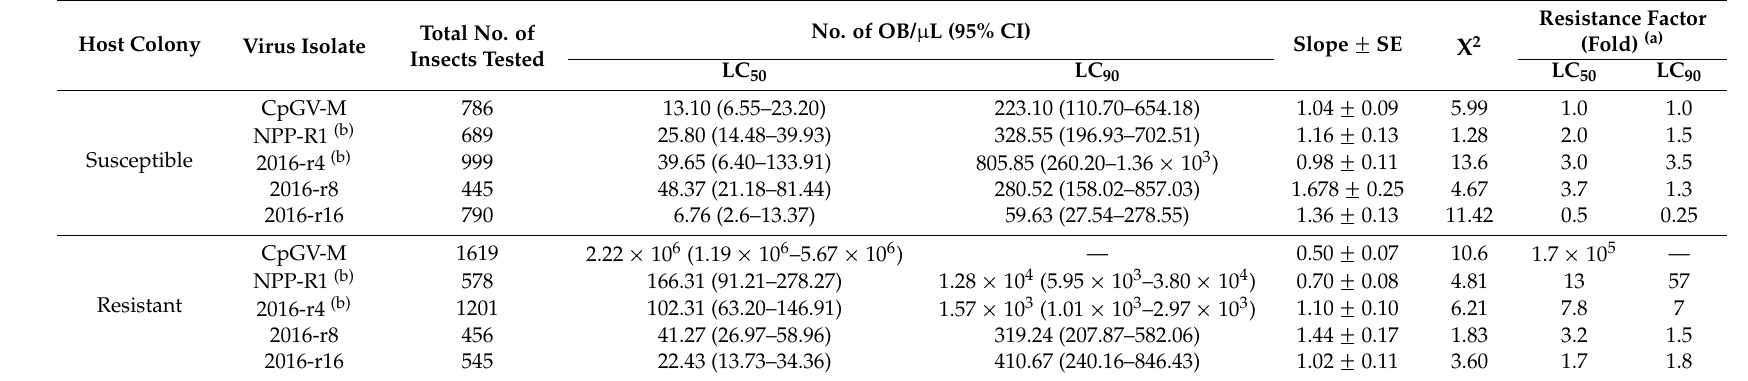
Table 2. Pathogenicities, measured by lethal concentration (LC) 50 and LC 90 of four viral isolates on Cydia pomonella laboratory colonies susceptible and resistant to CpGV-M.